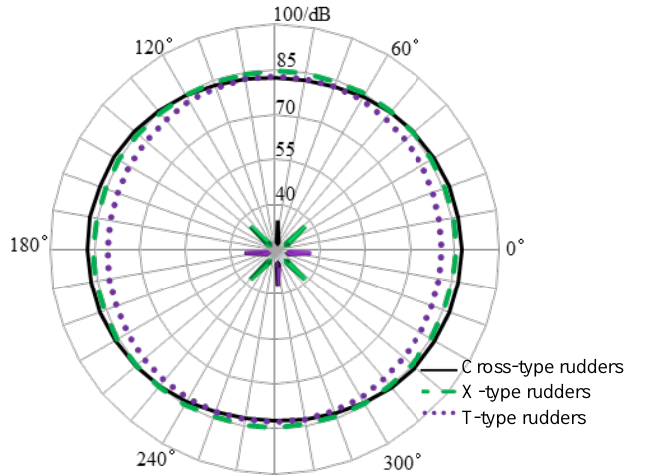
Figure 21. Directivity of sound pressure levels of different underwater vehicle stern rudder parts.